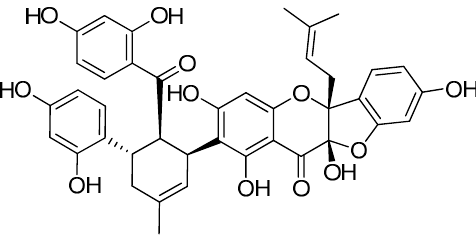
Figure 1. Chemical structure of sanggenon C.